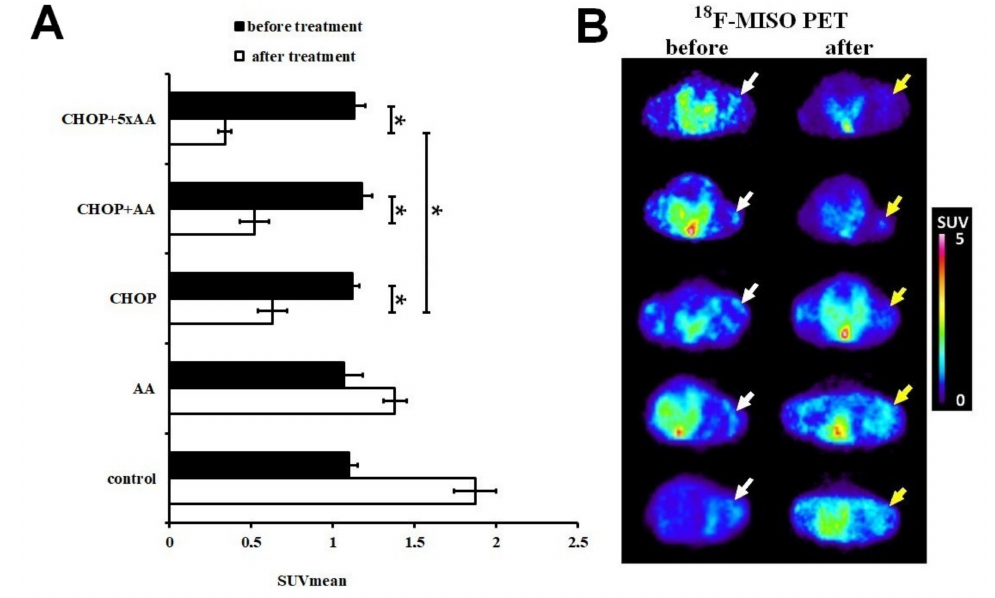
Figure 1. Comparative results of the in vivo PET analysis representing tissue hypoxia based on 18 F-MISO SUVmean activity in A20 / BalbC murine lymphomas before and after treatments. ( A ) Mean SUV values were similar in all untreated tumors (day 22, black columns). Five days after administration of the drug combinations (day 28, empty columns) a di ff erential response was observed: general increase of SUVmean was measured in the untreated and AA groups, while a significant reduction in SUVmean was the result of CHOP and its combinations. AA adjuvant to CHOP further decreased 18 F-MISO SUVmean values suggesting ongoing metabolic regression. ( B ) Representative decay-corrected miniPET images reflect the fading of tumor PET activity. Isotonic (0.9% NaCl) saline solution was used as a control. Animal horizontal cross sections are presented, central PET activity refers to 18 F-MISO accumulation in the bladder. White arrows: A20 tumors before therapy, yellow arrows: the same A20 tumors after treatment. SUV: standardized uptake value. SUV data is presented as mean ± SD of at least 4 tumors / group. Significance level: p ≤ 0.05